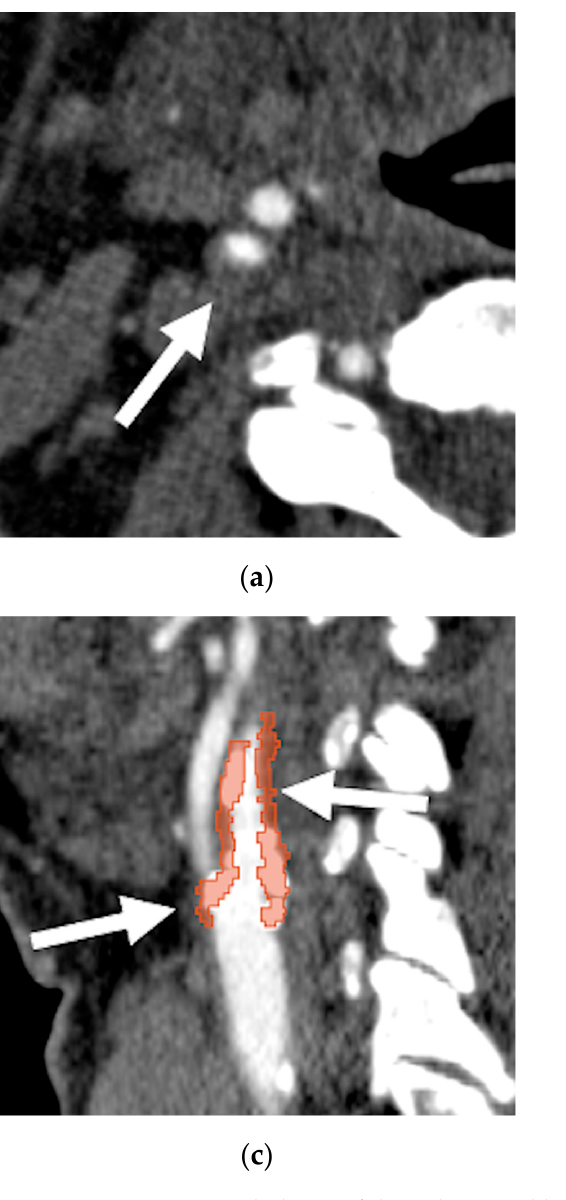
Figure 2. Symptomatic mixed plaque of the right carotid bifurcation extended to the proximal internal carotid artery: ( a ) the axial computed tomography angiography image shows the internal carotid artery plaque (arrow) that determined 70% lumen stenosis, following North American Symptomatic Carotid Endarterectomy Trial (NASCET) criteria [28]; the whole plaque was segmented manually with the open-source 3D Slicer software (https://www.slicer.org/, accessed on 1 October 2021) obtaining volumetric ROI as showed in ( b ) axial, ( c ) sagittal, and ( d ) coronal multiplanar reformatted reconstruction derived from computed tomography angiography (arrows).